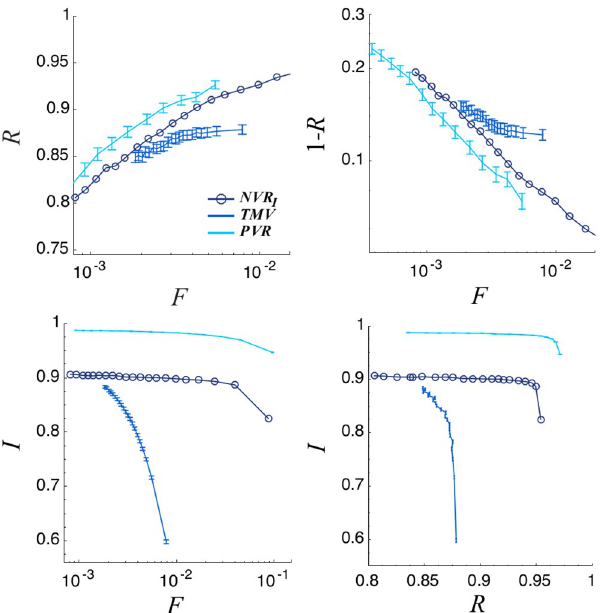
Fig 7. Top: Representativity versus normalized committee size (left), logarithmic plot of 1 − R versus normalized committee size (right). Bottom: Mean Committee integrity as a function of normalized committee size (left) and Representativity (right). The results correspond to the Networked Voting Rule ( NVR Voting ( TMV ) and a Perfect Voting Rule ( PVR ) with parameters N NVR I we use a Erdo¨s-Re´nyi network with h k i = 40. For the TVR we set the initial number of candidates N c = 100. Results are averaged over 100 different realizations. See the main text for a detailed explanation of the voting